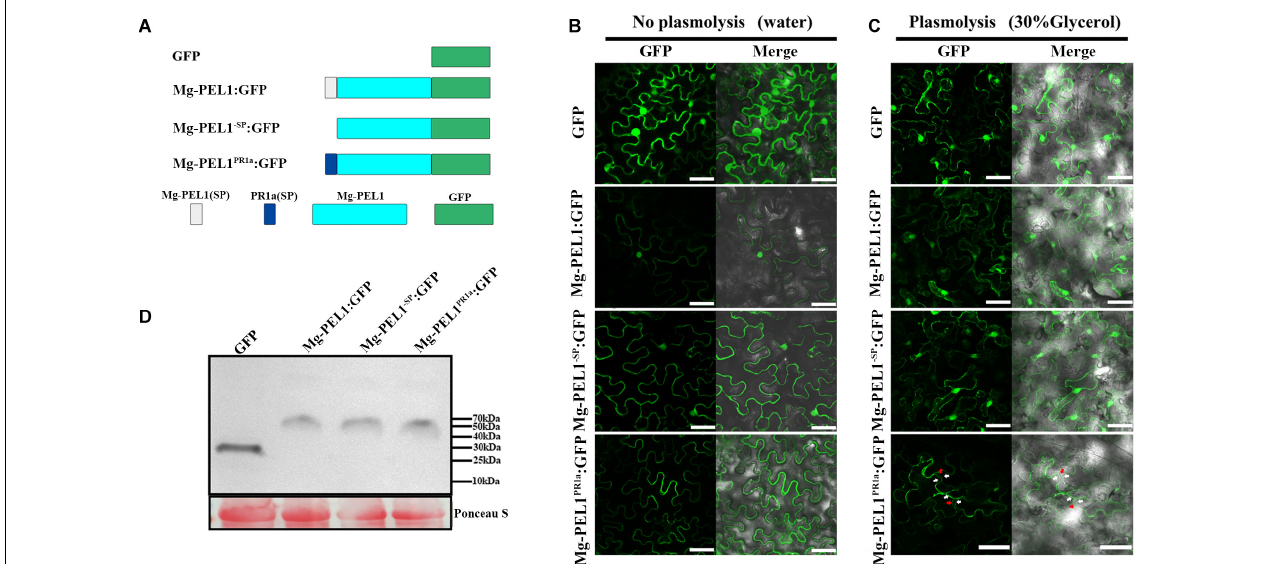
FIGURE 7 | Subcellular localization of Mg-PEL1 in plant cells. (A) Schematic diagram showing the protein structures Mg-PEL1:GFP, Mg-PEL1 - SP :GFP, Mg-PEL1 PR1a :GFP and GFP. (B) Agrobacterium stain GV3101 carrying fusion constructs Mg-PEL1: GFP, Mg-PEL1 - SP : GFP, Mg-PEL1 PR1a :GFP and the GFP control were transiently expressed in Nicotiana benthamiana leaves. (C) N. benthamiana leaves expressing Mg-PEL1: GFP, Mg-PEL1 - SP : GFP, Mg-PEL1 PR1a : GFP and GFP were treated with 30% glycerol for plasmolysis. GFP signals were observed at 2 d after infiltration. Red arrows indicate plant cell wall, and white arrows indicate plasma membrane. Scale bar = 100 µ m. (D) Western blotting confirmed the expression of Mg-PEL1: GFP, Mg-PEL1 - SP : GFP, Mg-PEL1 PR1a : GFP and GFP in N. benthamiana leaves. Ponceau S staining was used to show equal loading.